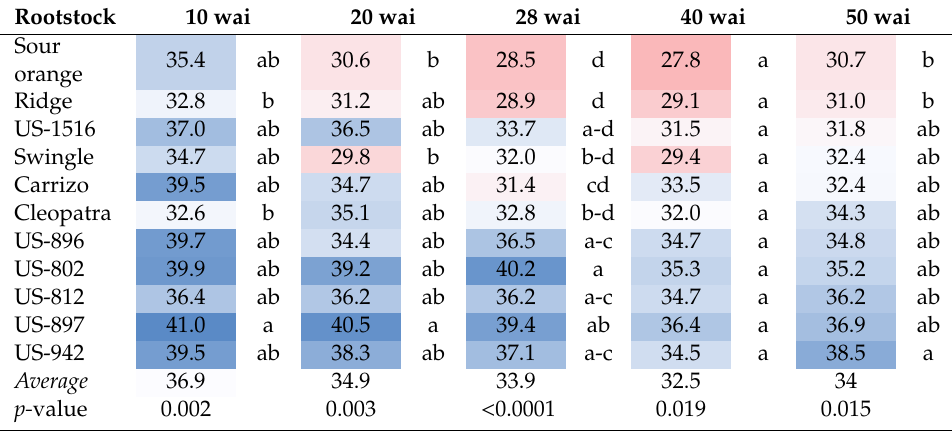
Table 3. Root Ct-values of infected plants used for assessment of horticultural parameters.